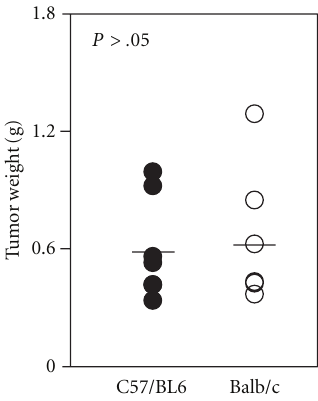
Figure 4: Engraftment of K562 erythroleukemia cell line into Rag-2 − / − Jak3 − / − mice. K562 cell line (5 × 10 6 cells/ mouse) was subcutaneously transplanted into Rag-2 − / − Jak3 − / − mice. Three weeks after transplantation, mice were sacrificed and the tumors